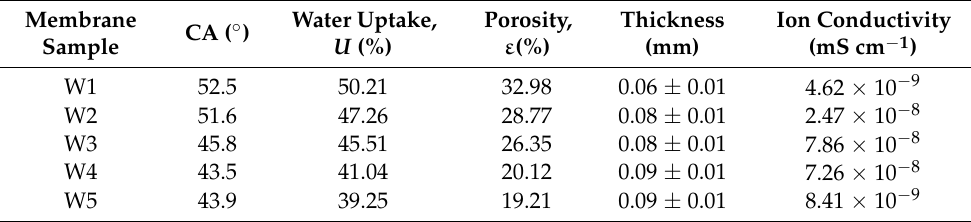
Table 4. The CA, water uptake, porosity, and thickness of the PIM and MM-PIM samples. Membrane